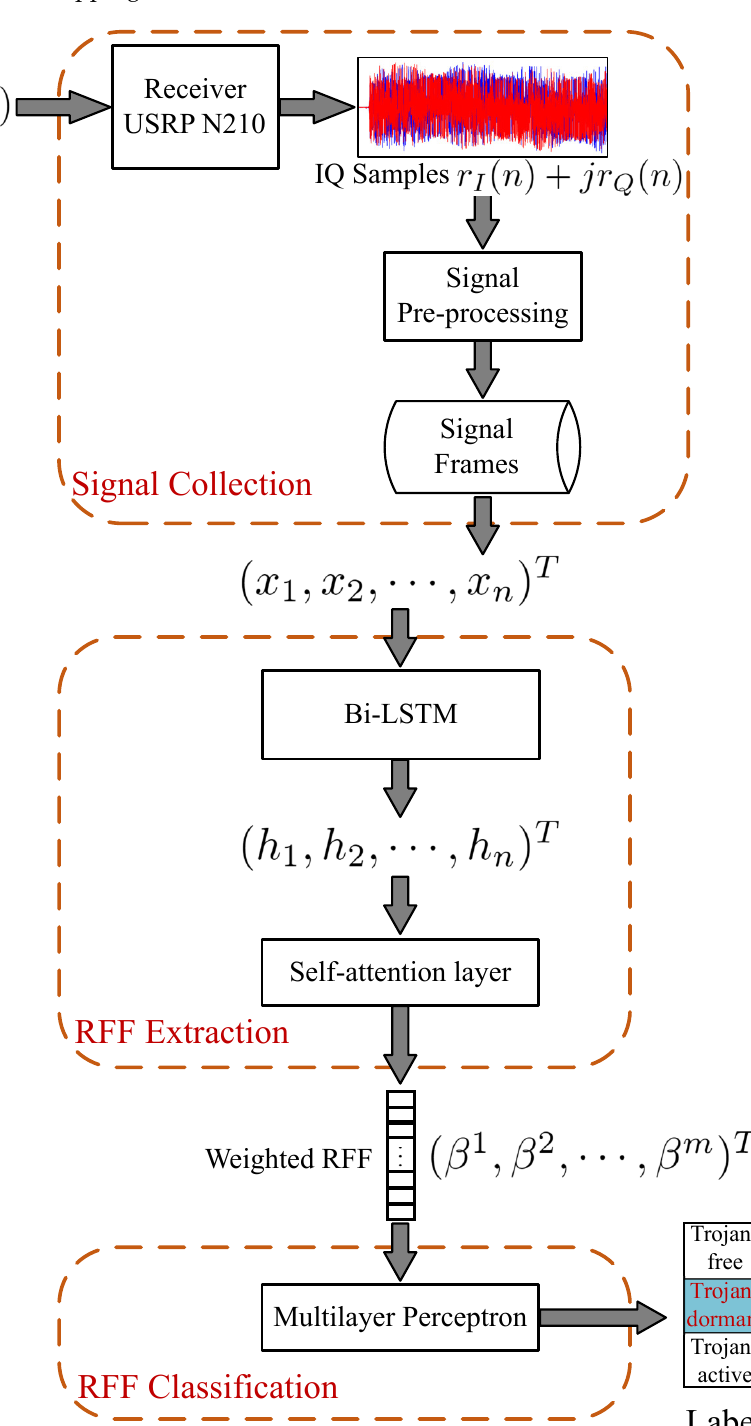
Figure 3. Structure diagram of the proposed hardware Trojan-detection